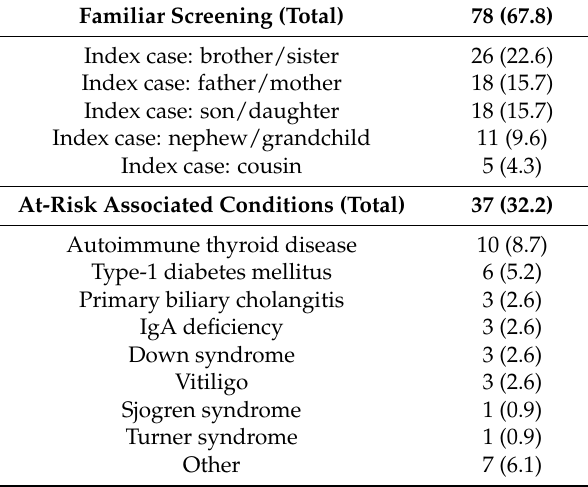
Table 1. Conditions which justified the screening for celiac disease in at-risk